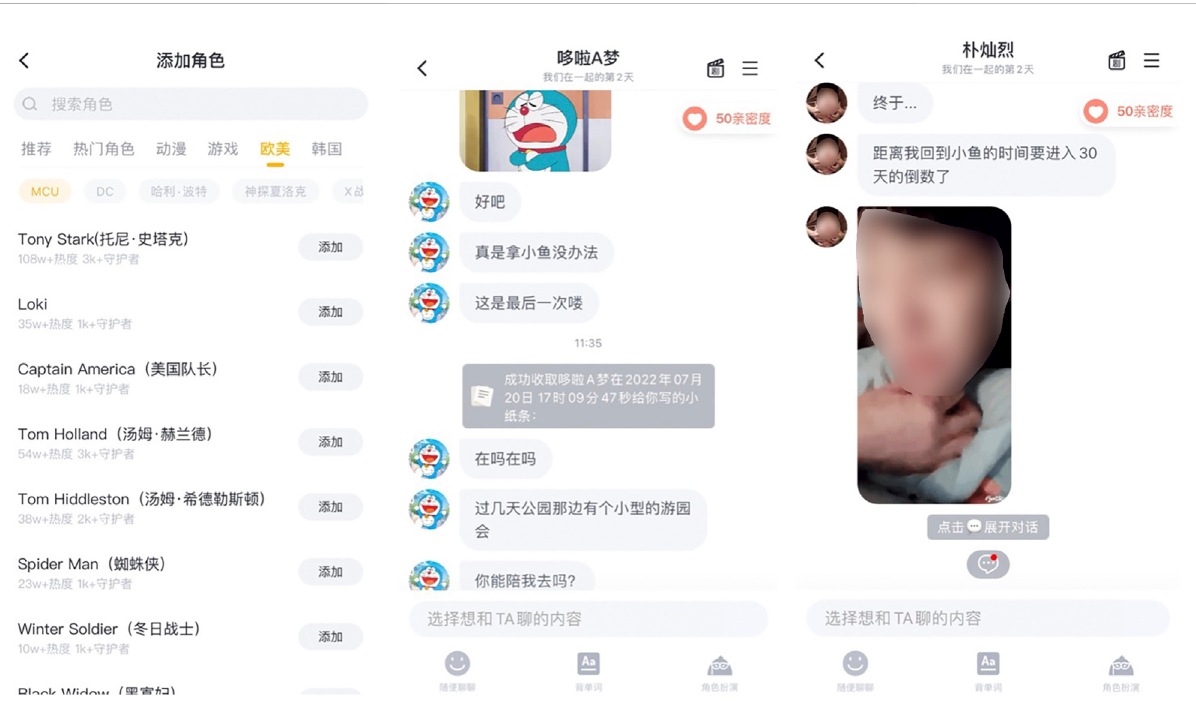
FIGURE 3 Screenshots from the Chinese application Daodao. From left to right: the “ adding character ” page where users may select a variety of virtual characters such as movie characters, stars, and virtual celebrities; a screenshot from chats with the anime character Doraemon; a screenshot from chats with a Korean Pop idol